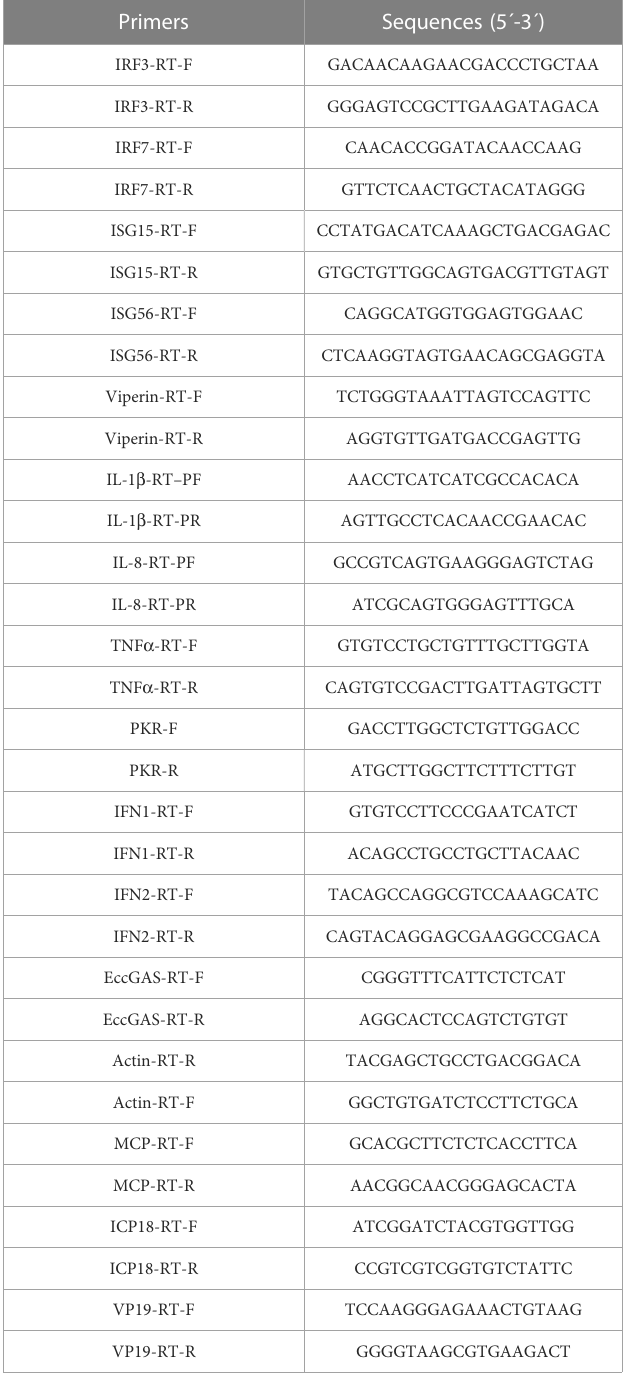
TABLE 1 Primers used for host and viral genes expression